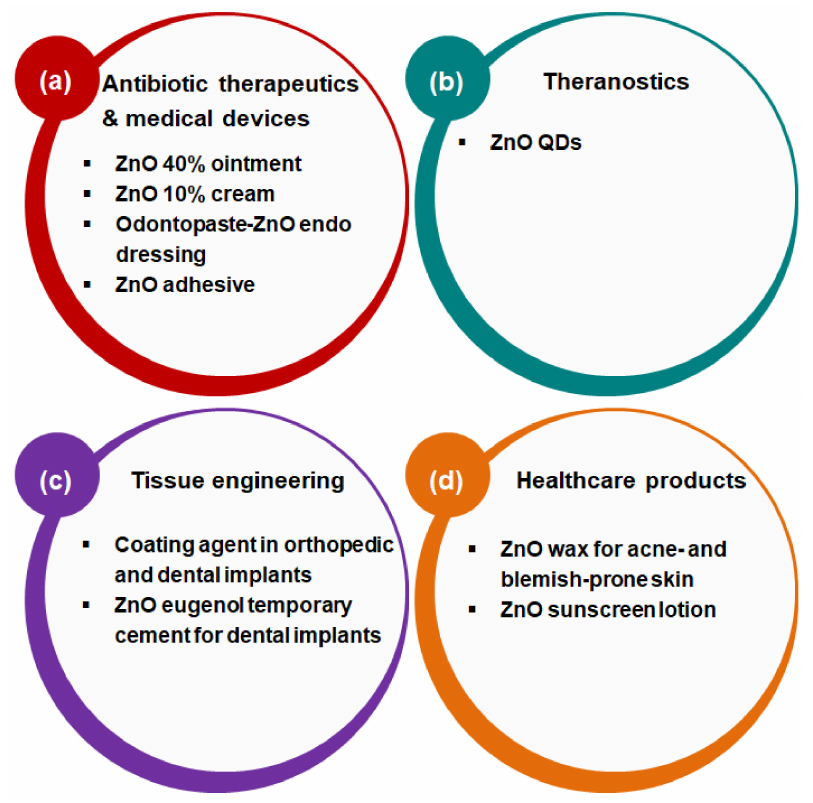
Figure 2. Functional approaches of ZnO materials for biomedical applications: ( a ) antibiotic thera- peutics and medical devices, ( b ) theranostics, ( c ) tissue engineering, and ( d ) healthcare